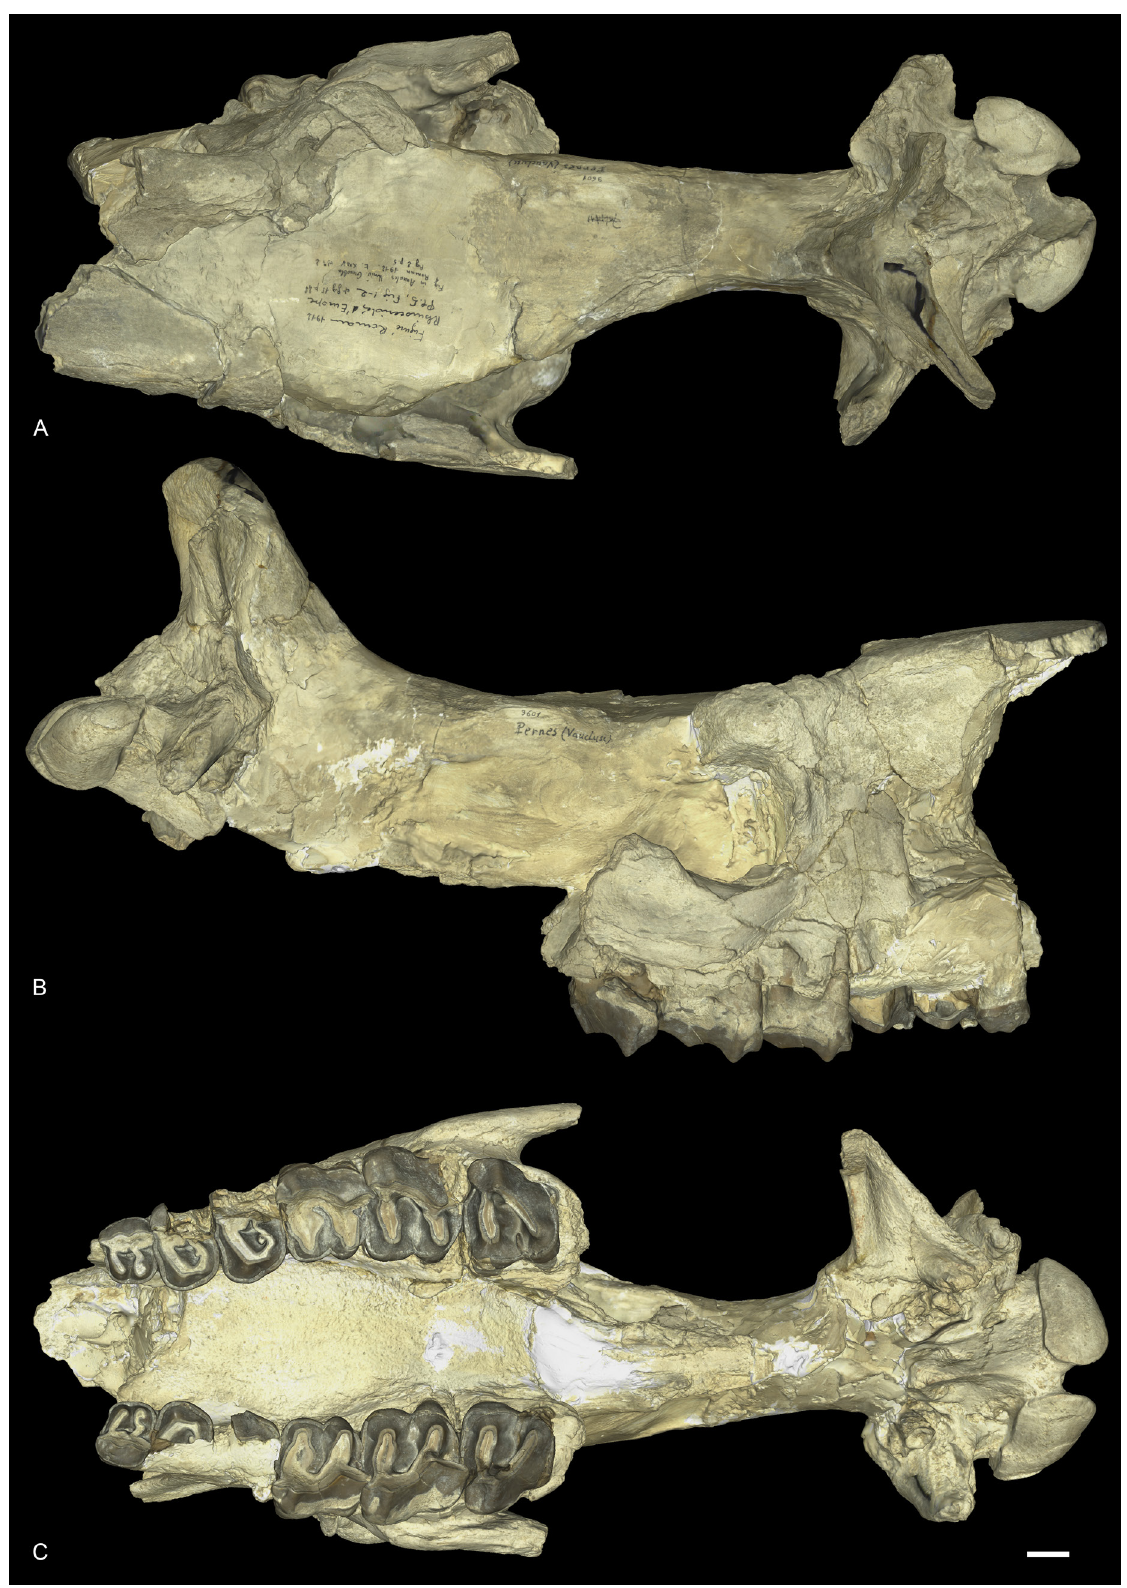
Fig. 8. Ronzotherium elongatum Heissig, 1969 from Pernes (early Oligocene?). Skull FSL-9601. A . Dorsal view. B . Right lateral view. C . Ventral view. Scale bar: 2